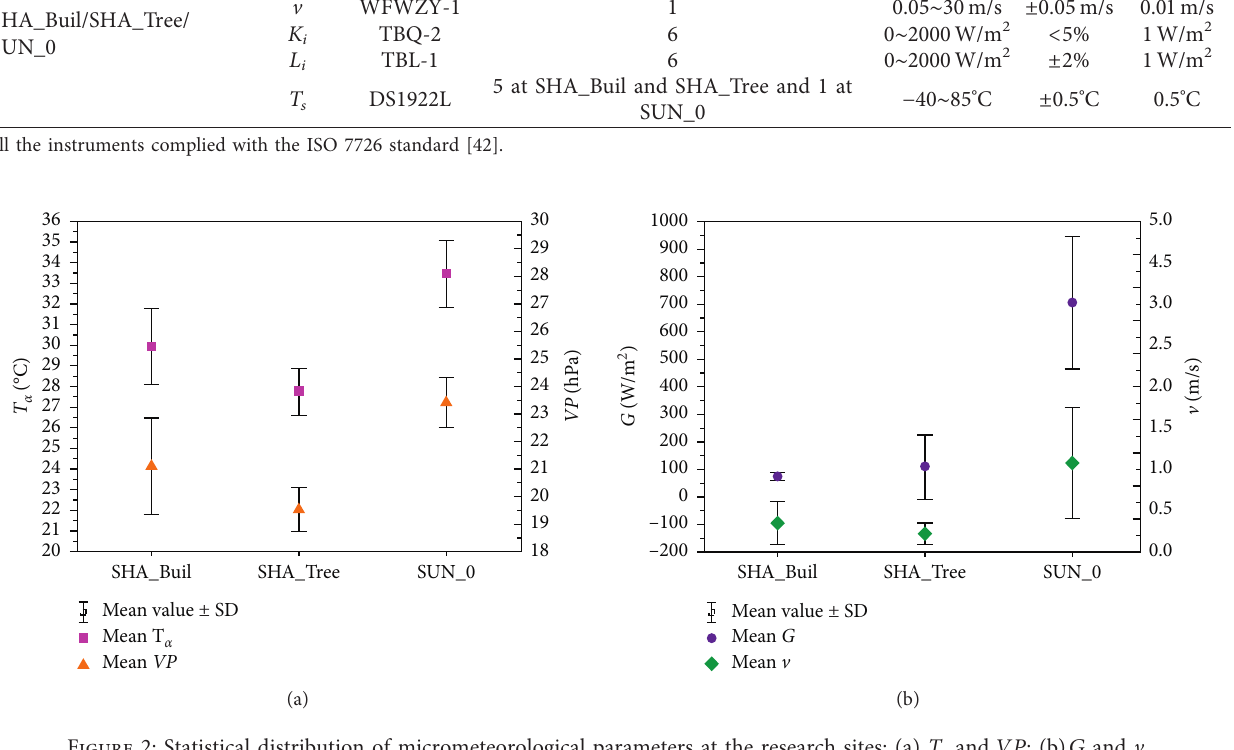
VP ; (b) G and v . a and